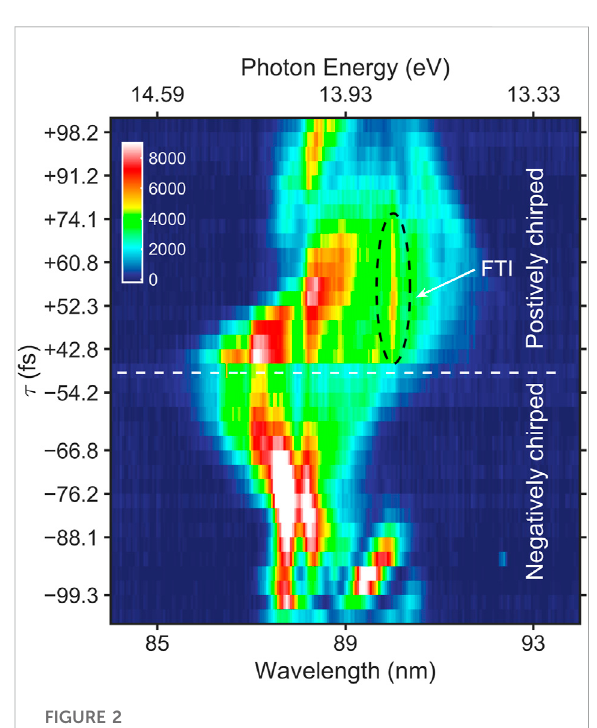
FIGURE 2 Variation of spectrum with laser chirp. The corresponding FWHM pulse duration τ shown as the y -axis varies from − 100 fs to +100 fs, where “ + ” and “ − ” signs indicate the positive and negative chirp, respectively. The FTI emission is marked by black dotted